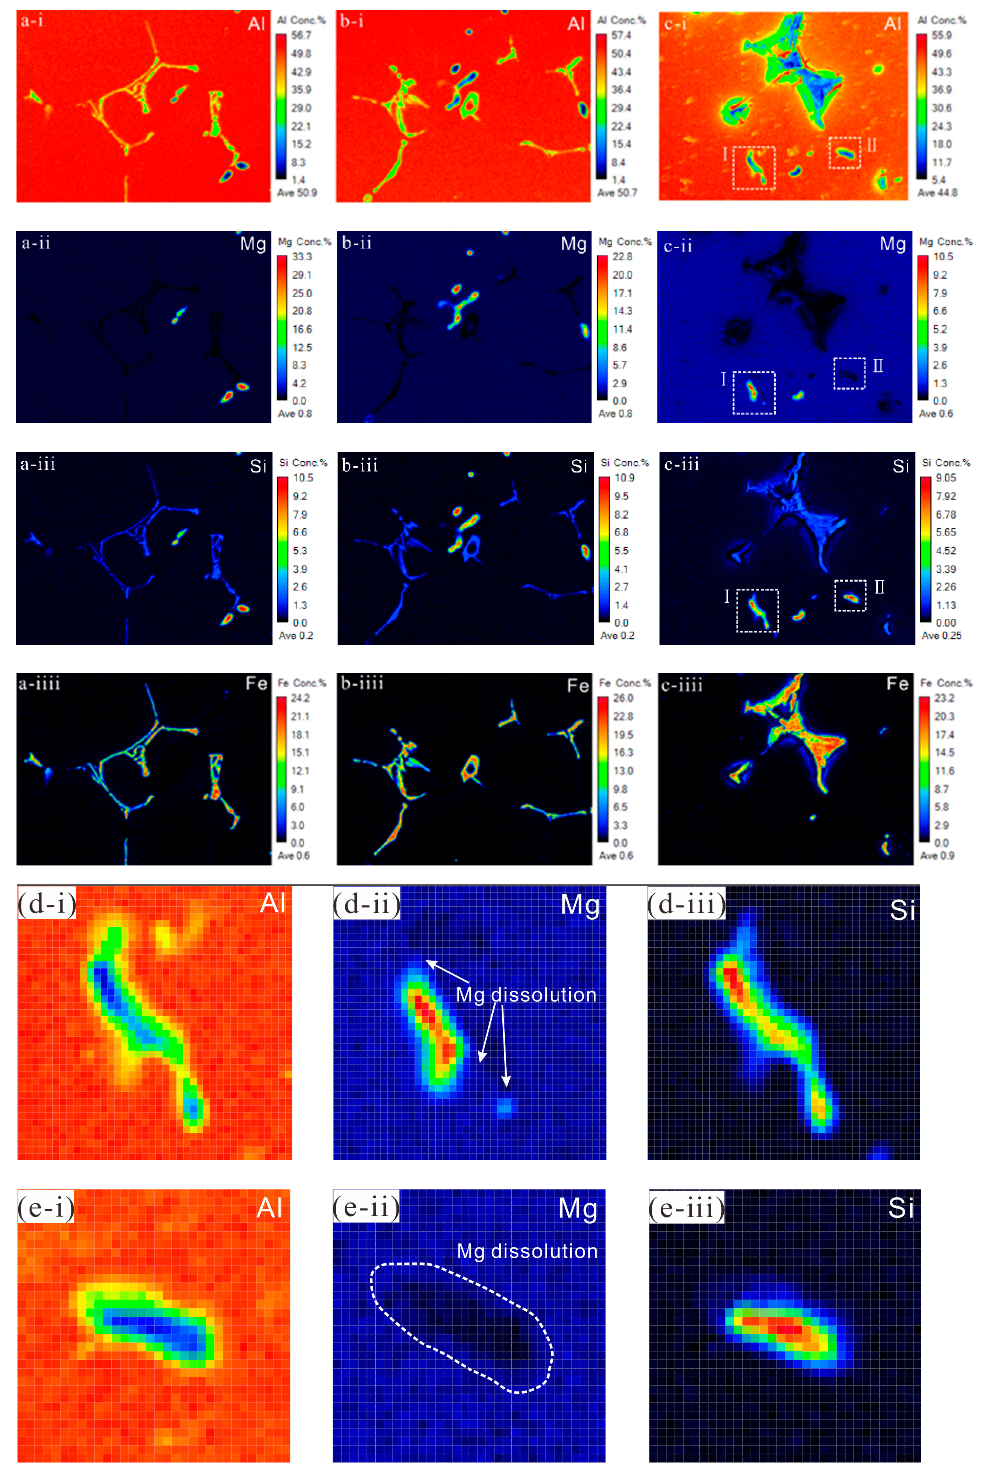
Figure 10. The change in element content (Al, Fe, Si, Mg) of samples aged 5 h at 180 °C immersed in 3.5% NaCl solution for different times: ( a )-( a-iiii ) 0 h; ( b )-( b-iiii ) 1 h; and ( c )-( c-iiii ) 24 h. ( d-i )- ( d-iii ) and ( e-i )- ( e-iii ) are enlarged images of regions ( I ) and ( II ) in ( c-i ) and ( c-ii ), respectively.